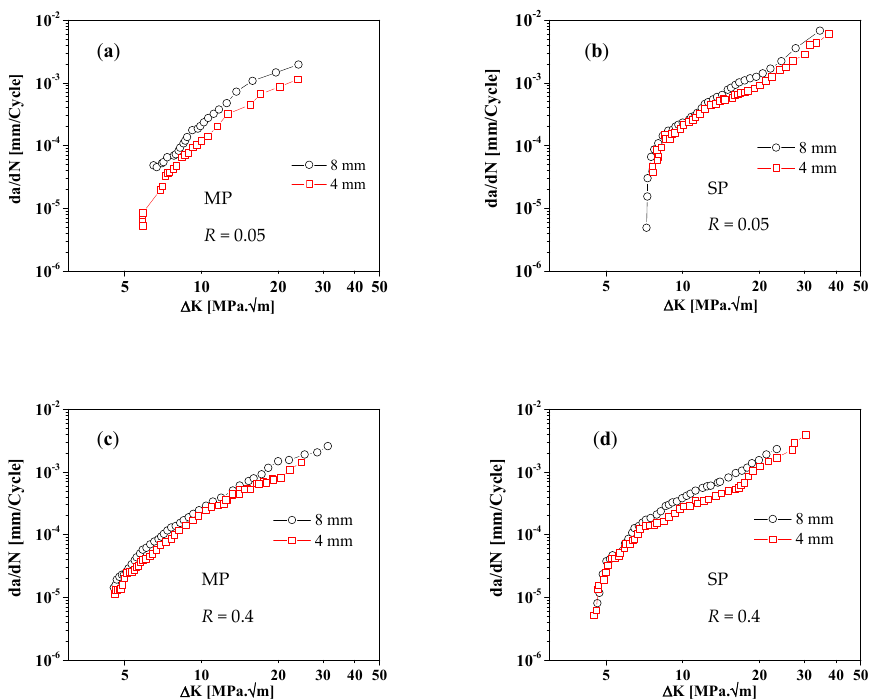
Figure 5. Thickness effect on the da/dN- ∆ K curves for specimens: ( a ) MP, R = 0.05; ( b ) SP, R = 0.05; ( c ) MP, R = 0.4; and ( d ) SP, R = 0.4.